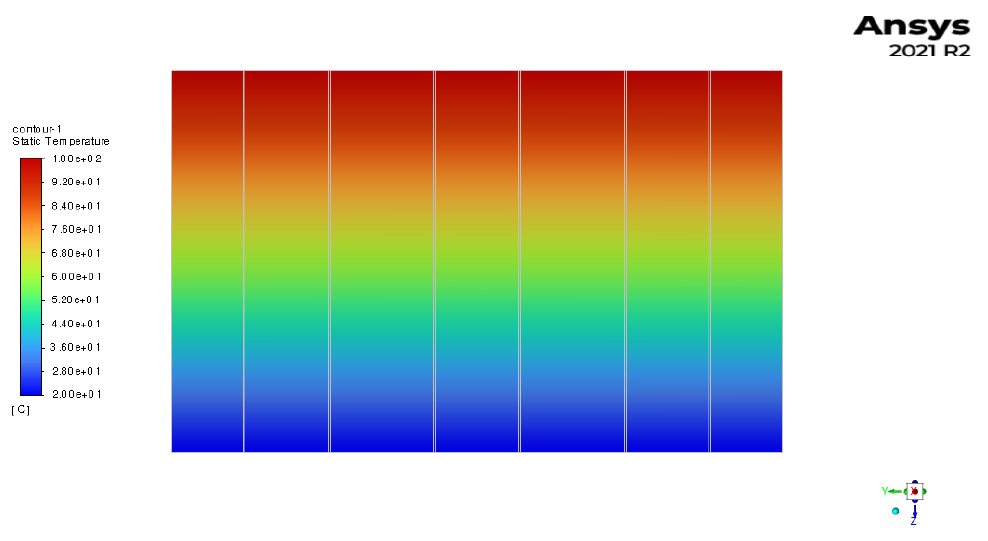
Figure 18. ANSYS-Fluent simulation result.